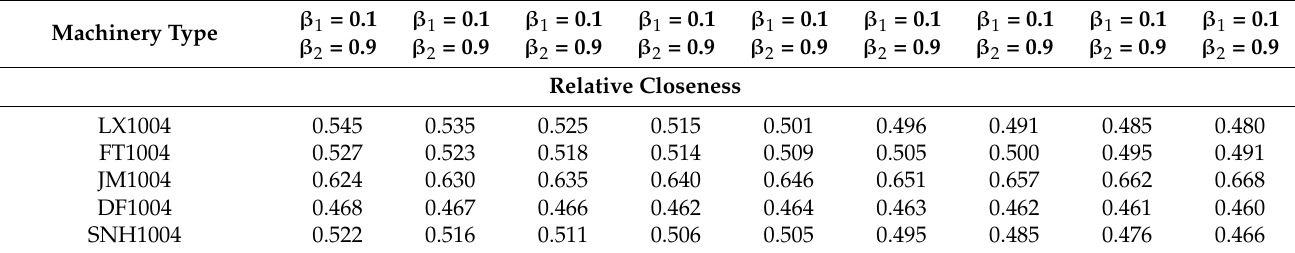
Table 8. Sorting of 73.5 kW power machinery types with different values of β 1 , β 2